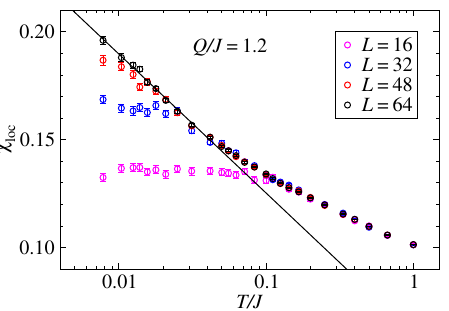
FIG. 20. Temperature dependence of the local susceptibility of the random- Q model at its AFM-RS transition for several different system sizes. The line is a fit of the L ¼ 64 low- T points to the logarithmically divergent form in Eq. (18).